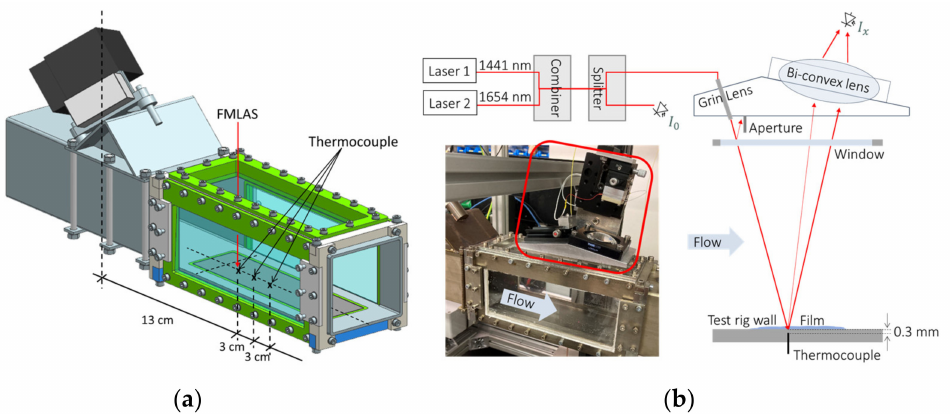
Figure 3. ( a ) Measurement section with location of film thickness measurement and thermocouples. ( b ) Film thickness sensor as a schematic view and mounted on top of the optical access of the SCR test